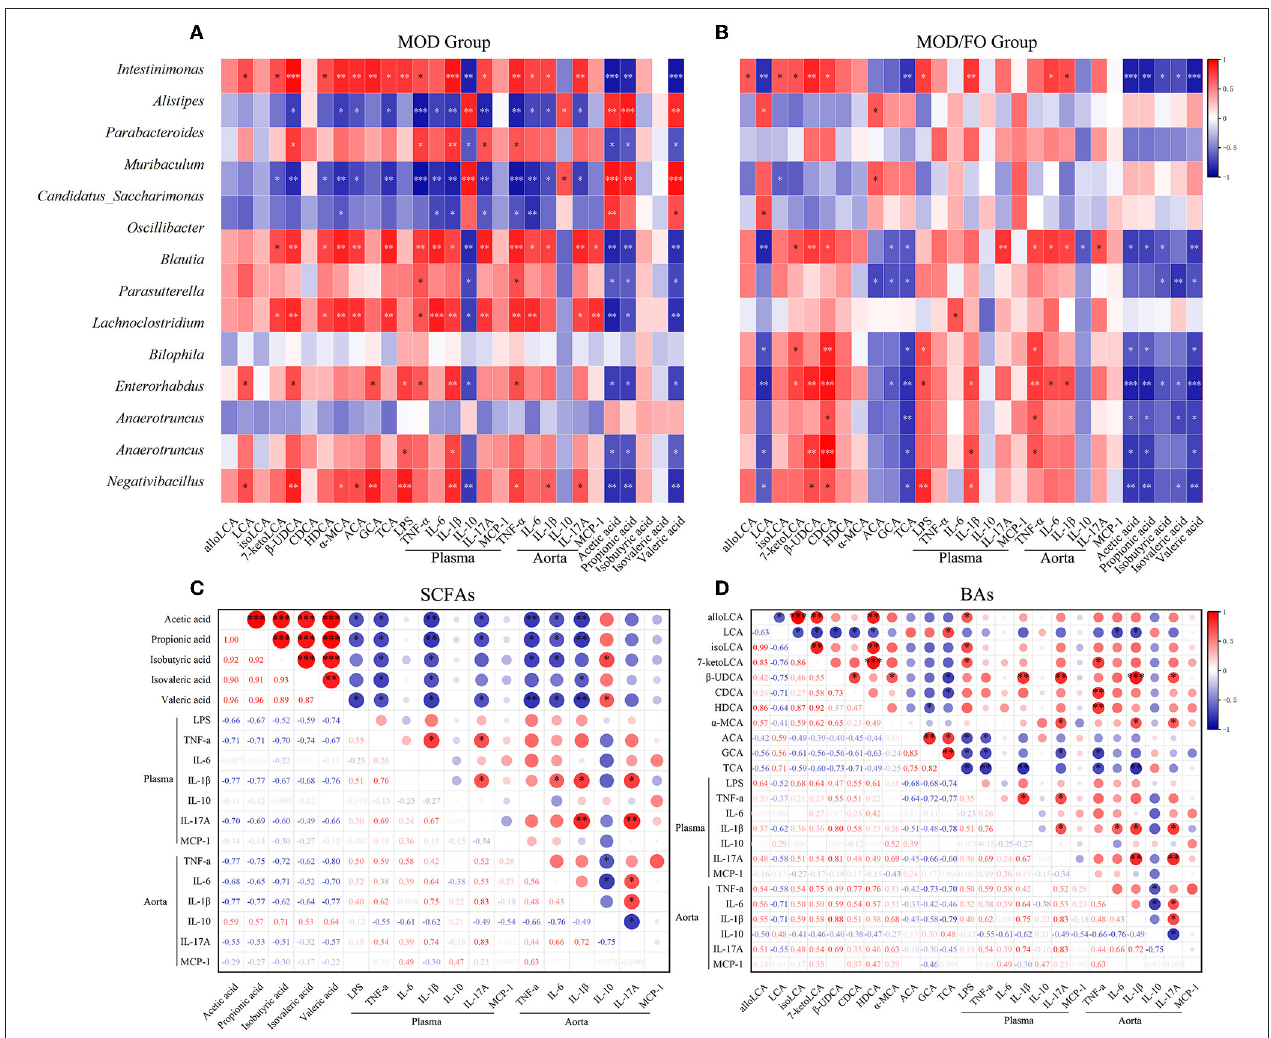
FIGURE 6 | Correlation analysis among bacteria, lipopolysaccharide (LPS), short-chain fatty acids (SCFAs), bile acids (BAs), and inflammatory cytokines. (A) Correlation among the differential bacteria with metabolites (SCFAs and BAs), LPS, and plasma/aortic inflammatory indicators in MOD group. (B) Correlation among the differential bacteria with metabolites (SCFAs and BAs), LPS, and plasma/aortic inflammatory indicators in MOD/FO group. (C) Correlation among SCFAs with LPS and plasma/aortic inflammatory indicators. (D) Correlation among BAs with LPS and plasma/aortic inflammatory indicators. * P < 0.05, ** P < 0.01, *** P < 0.001. Red and blue represent the positive or negative